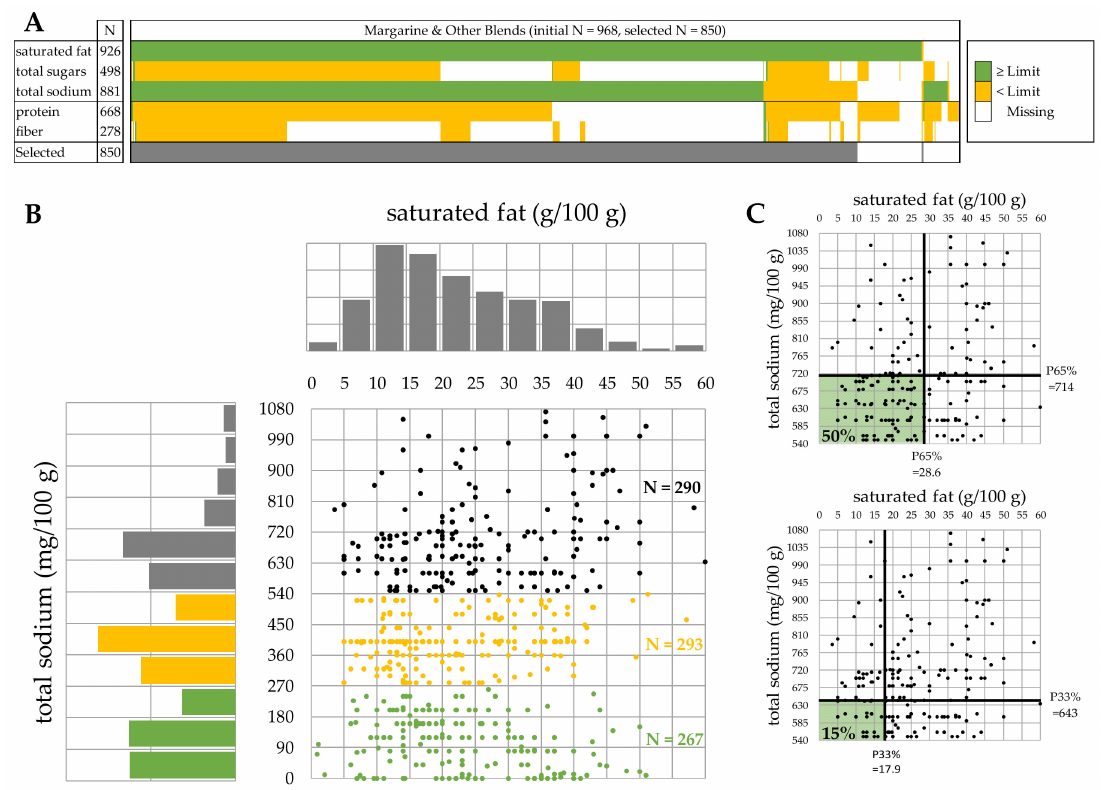
Figure 2. Illustration of the three algorithms using category “margarine and other blends”: identification of category- relevant nutrients ( A ), refinement of initial product categorization ( B ) and calculation of category specific nutrient thresholds for the “highly salted” category ( C